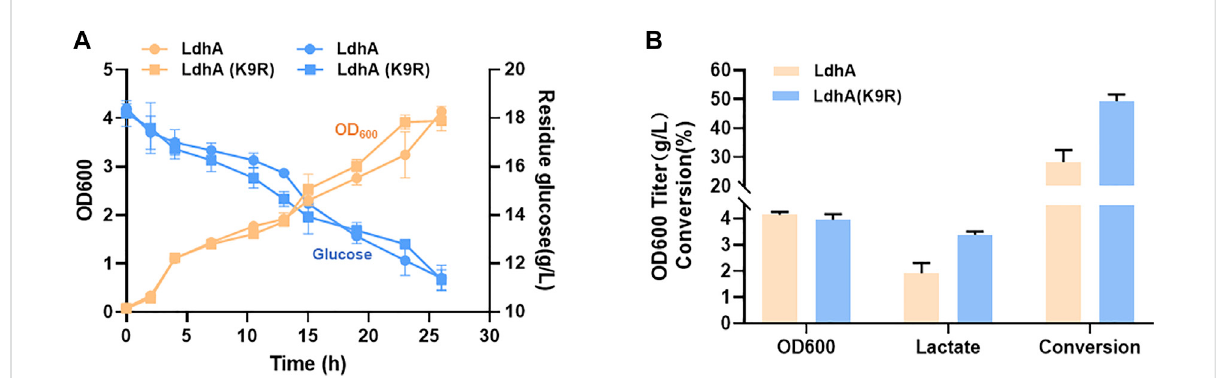
FIGURE 6 K9R mutant improves lactate production. (A) The cell growth and glucose consumption of wild LdhA and K9R mutant overexpressed strains. The yellow line represents the cell growth, the blue line represents the glucose consumption. (B) The biomass and metabolic pro fi les of wild LdhA and K9R mutant overexpressed strains in lactate